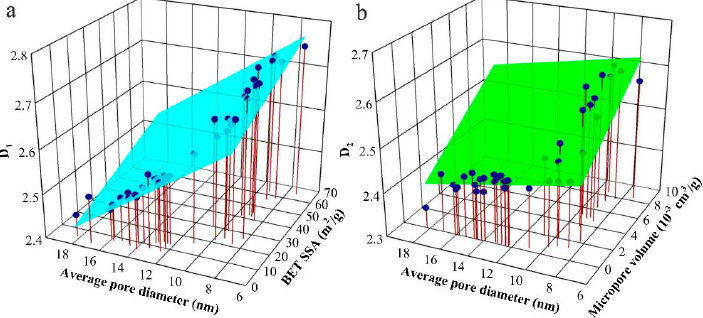
Table 1. Statistics of the regression models and the variance